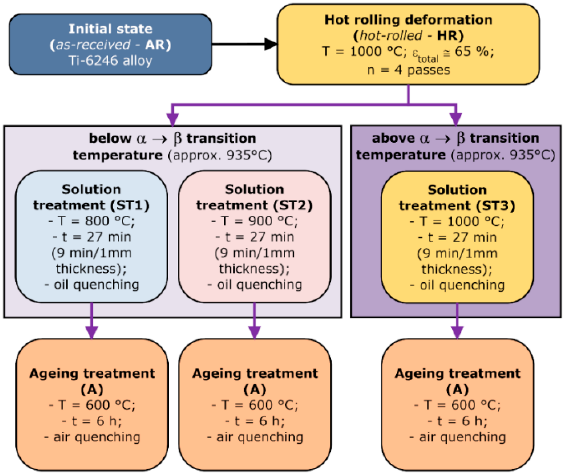
Figure 1. Schematic representation of the applied thermomechanical processing route.